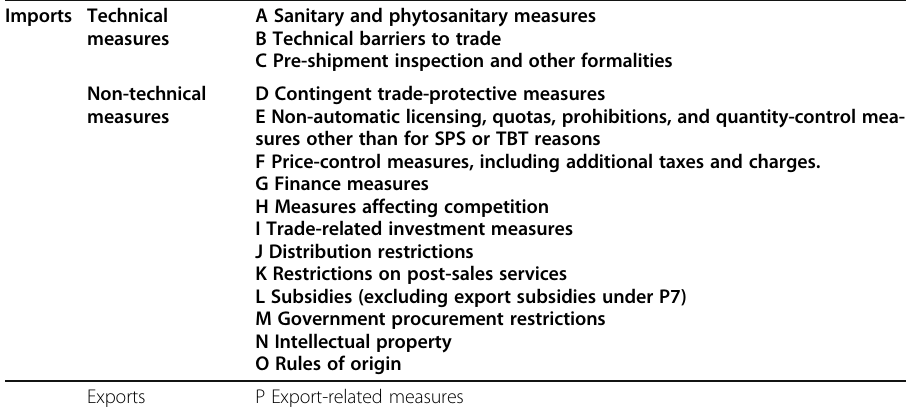
Table 4 Non-tariff measure classification by chapter Imports Technical